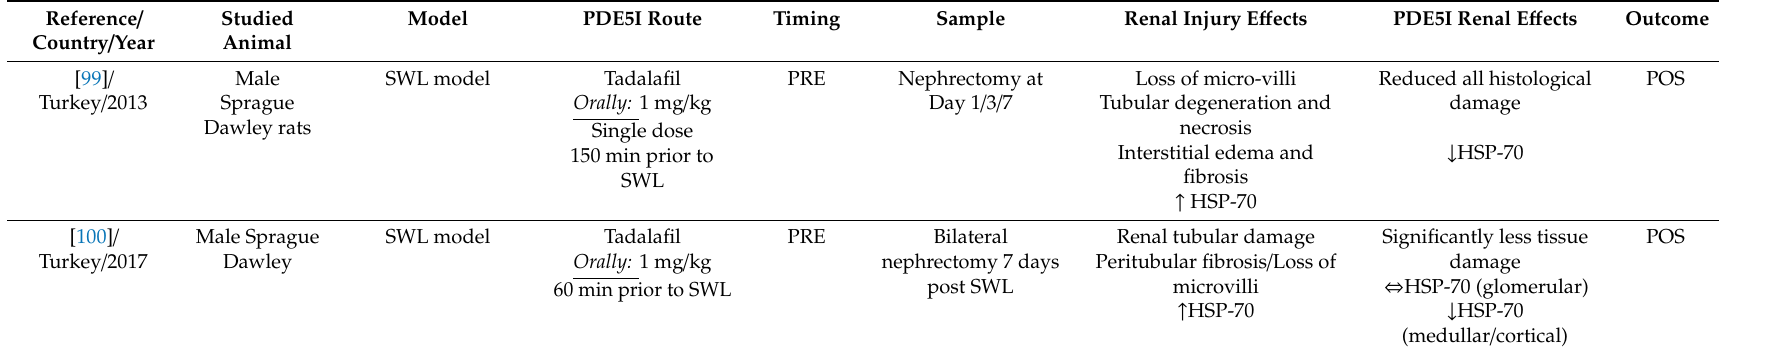
Table A2. Animal studies evaluating the potential reno-protective e ff ects of tadalafil.